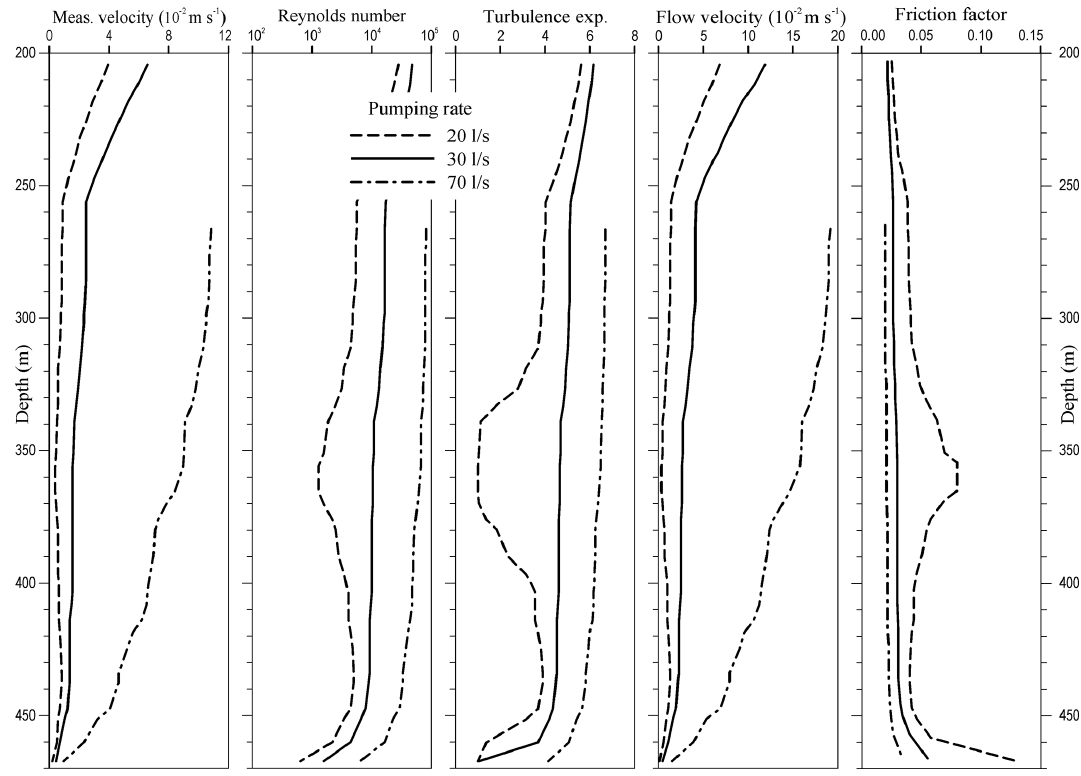
Figure 8. Results obtained for the main parameters in the case study and the calculated friction factors (Díaz-Curiel et al.,